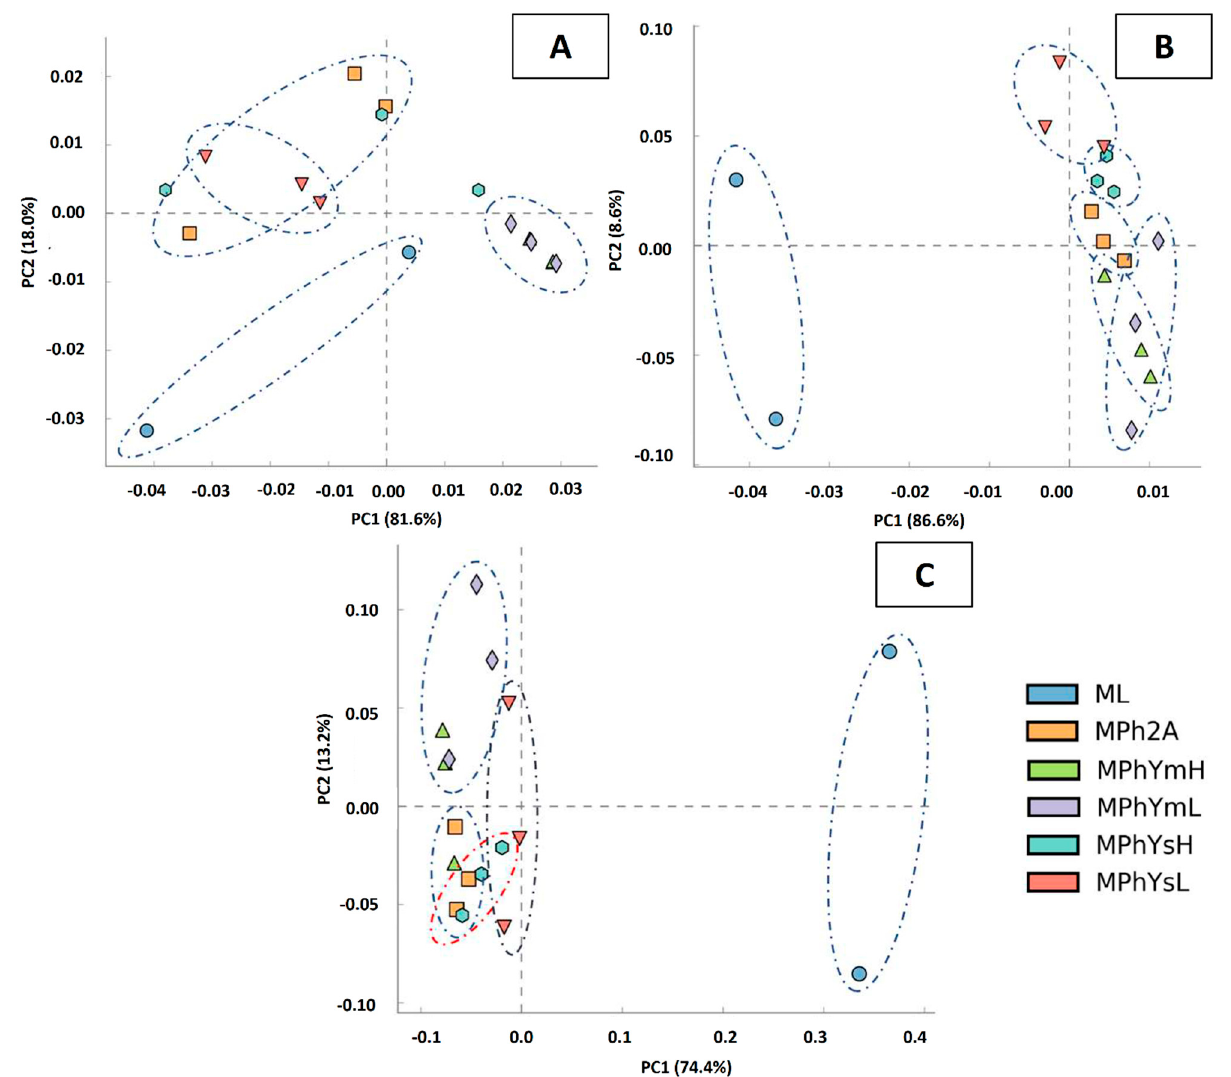
Figure 3. Based on MiSeq sequencing data, PCA analysis showing the distinct separation between the culturable communities developed on the three different culturing methods in relation to the culture-independent community at ( A ); phylum, ( B ); order, ( C ); genera levels. ML, culture-independent mother leaf; MPh2A, culture-dependent on R2A culture medium; MPhYmH, culture-dependent on homologous maize broth 25 ml L −1 ; MPhYmL, culture-dependent on homologous maize broth 5 ml L −1 MPhYsH culture-dependent on heterologous sunflower broth 25 ml L −1 ; MPhYsL, culture-dependent on heterologous sunflower broth 5 ml L −1 .